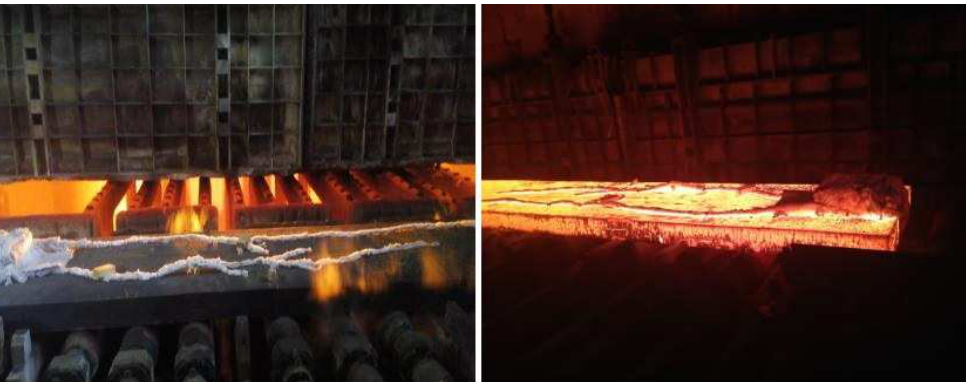
Figure 11. Charging and discharging state of the trial steel slab.